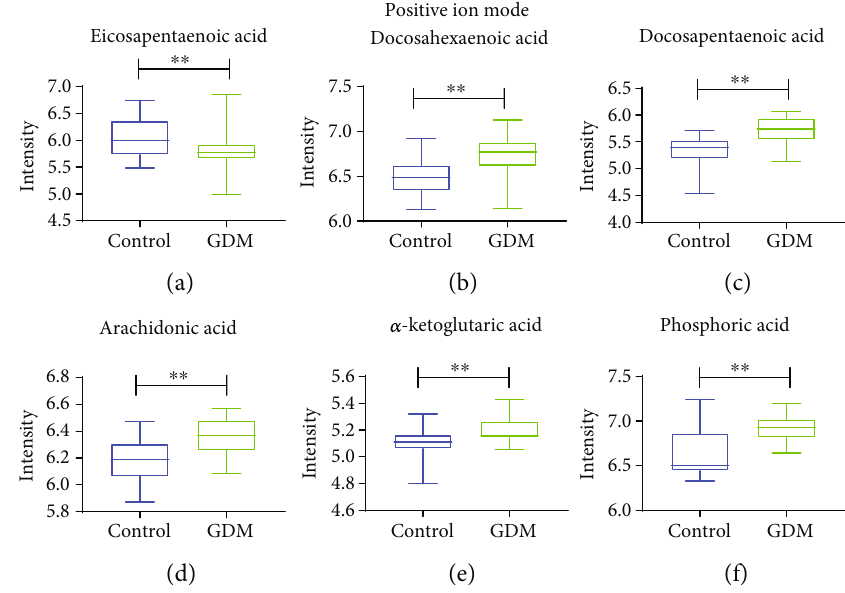
Figure 4: Boxplots of metabolites between control and GDM under positive ion mode. Student ’ s t -test for measurement data between two groups was performed for signi fi cant di ff erence. All data are expressed as the mean ± SEM , and the statistical signi fi cance level was set at ∗ p < 0 : 05 . ∗∗ p < 0 : 01